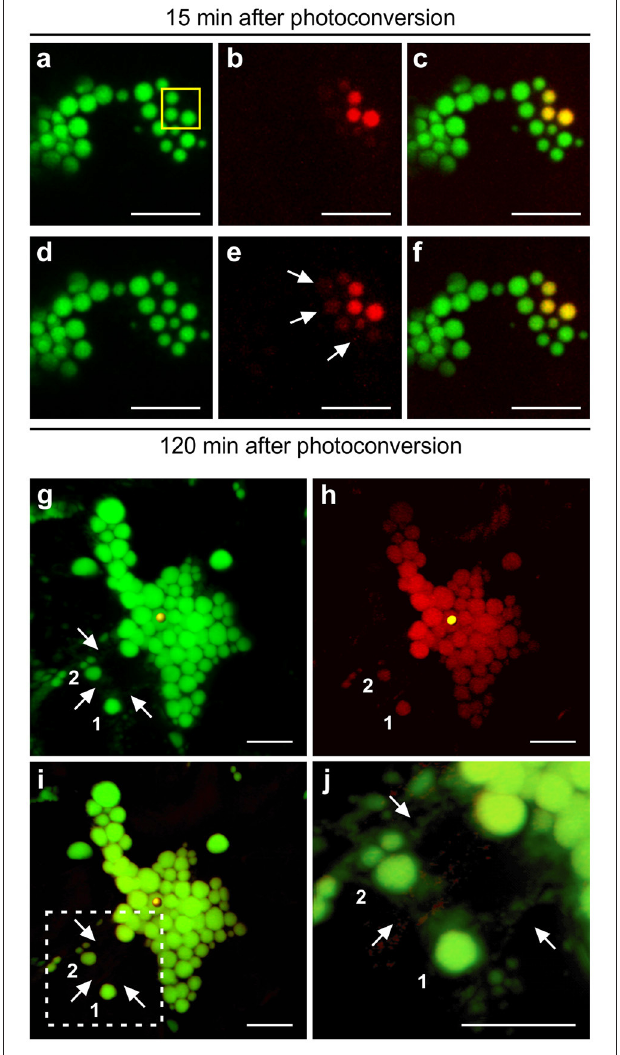
FIGURE 7 | Protein trafficking in Zera and ELP PBs upon photoconversion. (A–F) 3D visualization of a cluster of Zera-GFP PBs after photoconversion. (A–C) PBs highlighted with yellow box were irradiated twice with 7 min intervals. Z-stack images were acquired 15 min after photoconversion. (D–F) Z-stack images were acquired 120 min after the initial photoconversion. A small amount of photoconverted protein is trafficked from the region of irradiation into neighboring PBs shown with arrows. (G–J) ELP PBs communicate with one another through the ER. (G) 3D visualization of GFP-ELP PBs in the green channel. Region of irradiation is shown by a yellow sphere. PBs marked as 1 and 2 are located away from the region of irradiation and the cluster of PBs, and connected to the rest of PBs only through the ER network shown with arrows. (H) 3D visualization of photoconverted GFP-ELP PBs in the red channel. PBs marked as 1 and 2 photoconverted to red even though disconnect from the PB cluster. (I) Merge image of the green and red channels. (J) Close-up of the dotted square area in (I) . Arrows point to the ER network. All images were acquired at 4-dpi in sequential mode. Bar, 10 µ